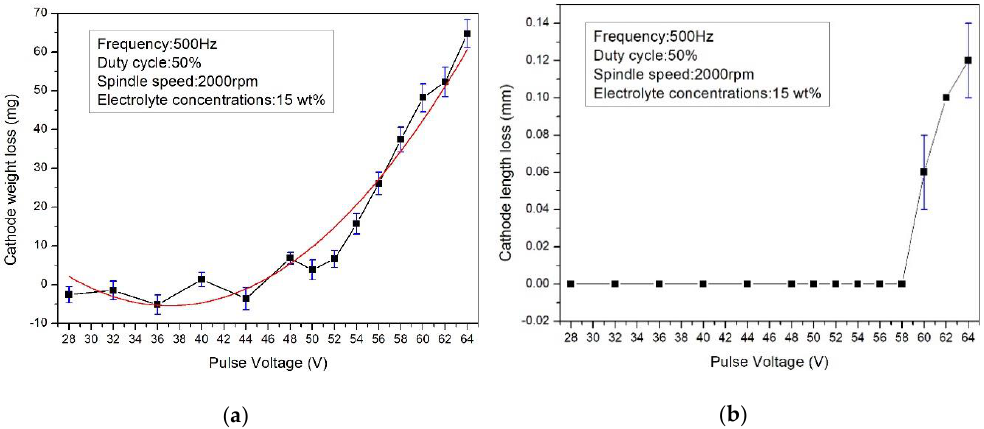
Figure 5. Relationship between the voltage and tool wear: ( a ) the cathode weight loss; and ( b ) the cathode length loss.